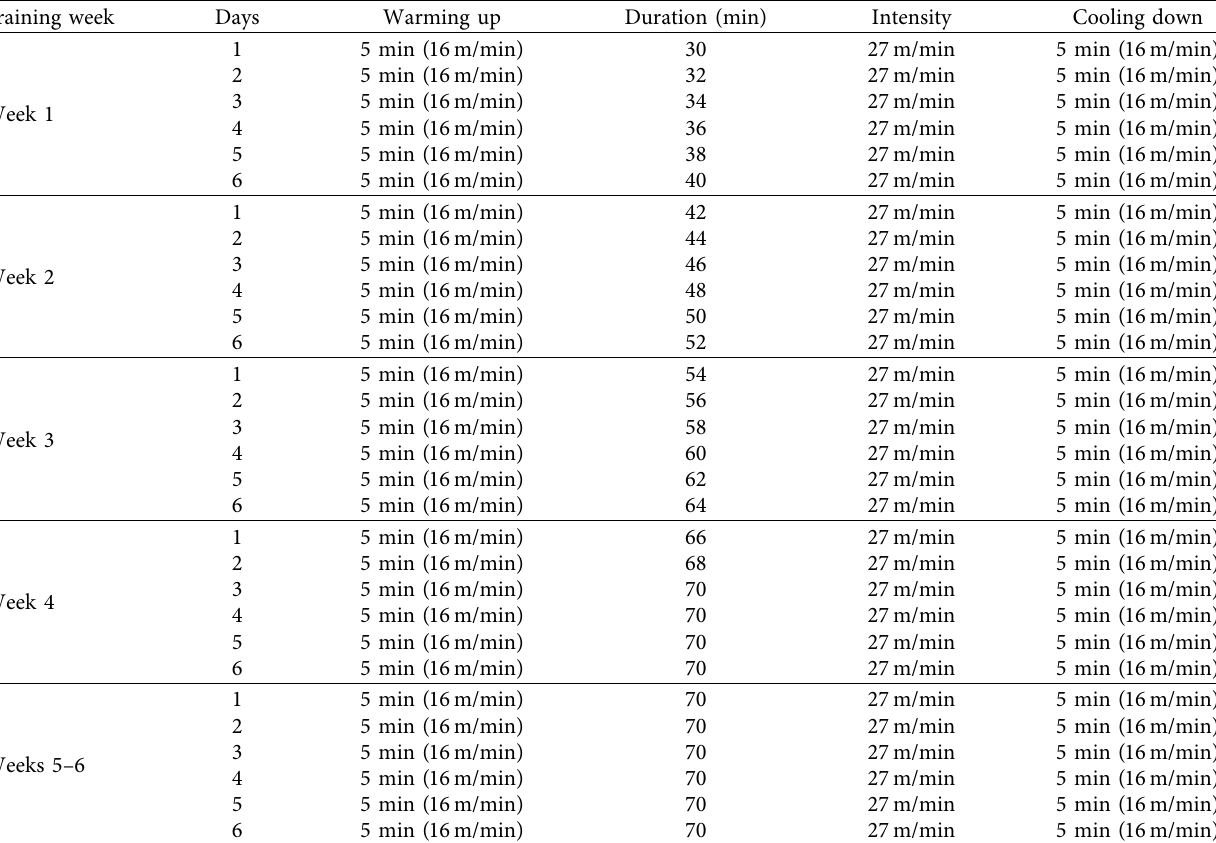
Table 1: Te continuous training protocol [23].